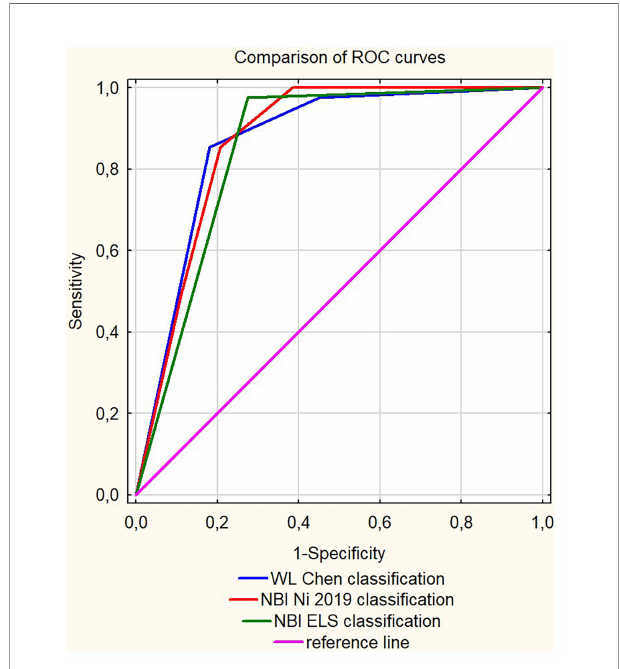
FIGURE 1 | The receiver operating characteristic (ROC) curves comparison for the analyzed clinical classi fi